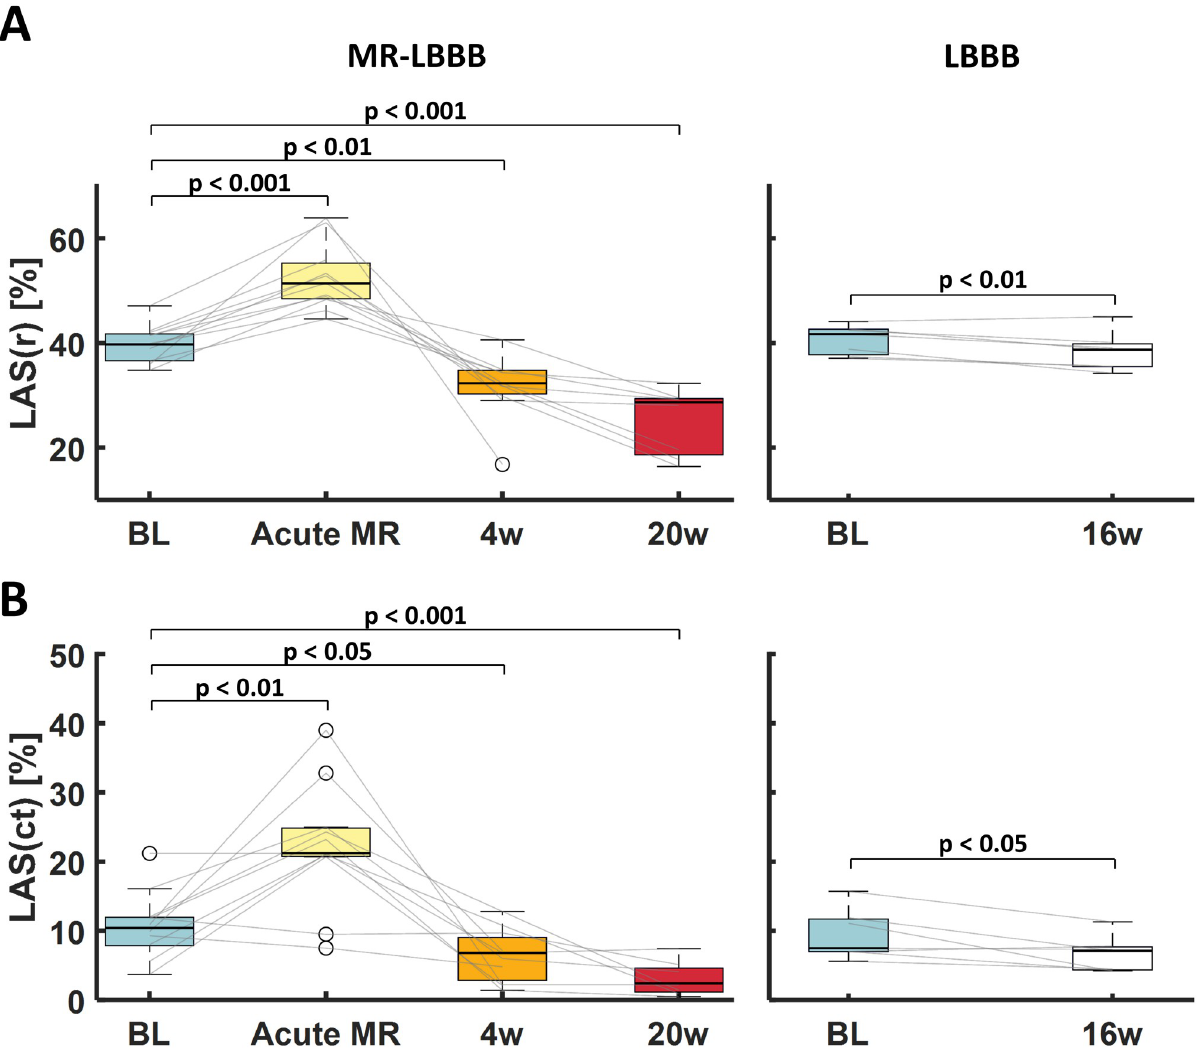
Fig 3. Chronological changes of left atrial strain. (A-B) Time course of LA reservoir (LAS(r)) and contractile (LAS(ct)) strain for each group (presented as boxplots and lines for individual animals). Statistical significance was assigned at p < 0.05. BL = baseline; LAS(r) = left atrial reservoir strain; LAS(ct) = left atrial contractile strain; LBBB = left bundle branch block, MR = mitral regurgitation; w = weeks.